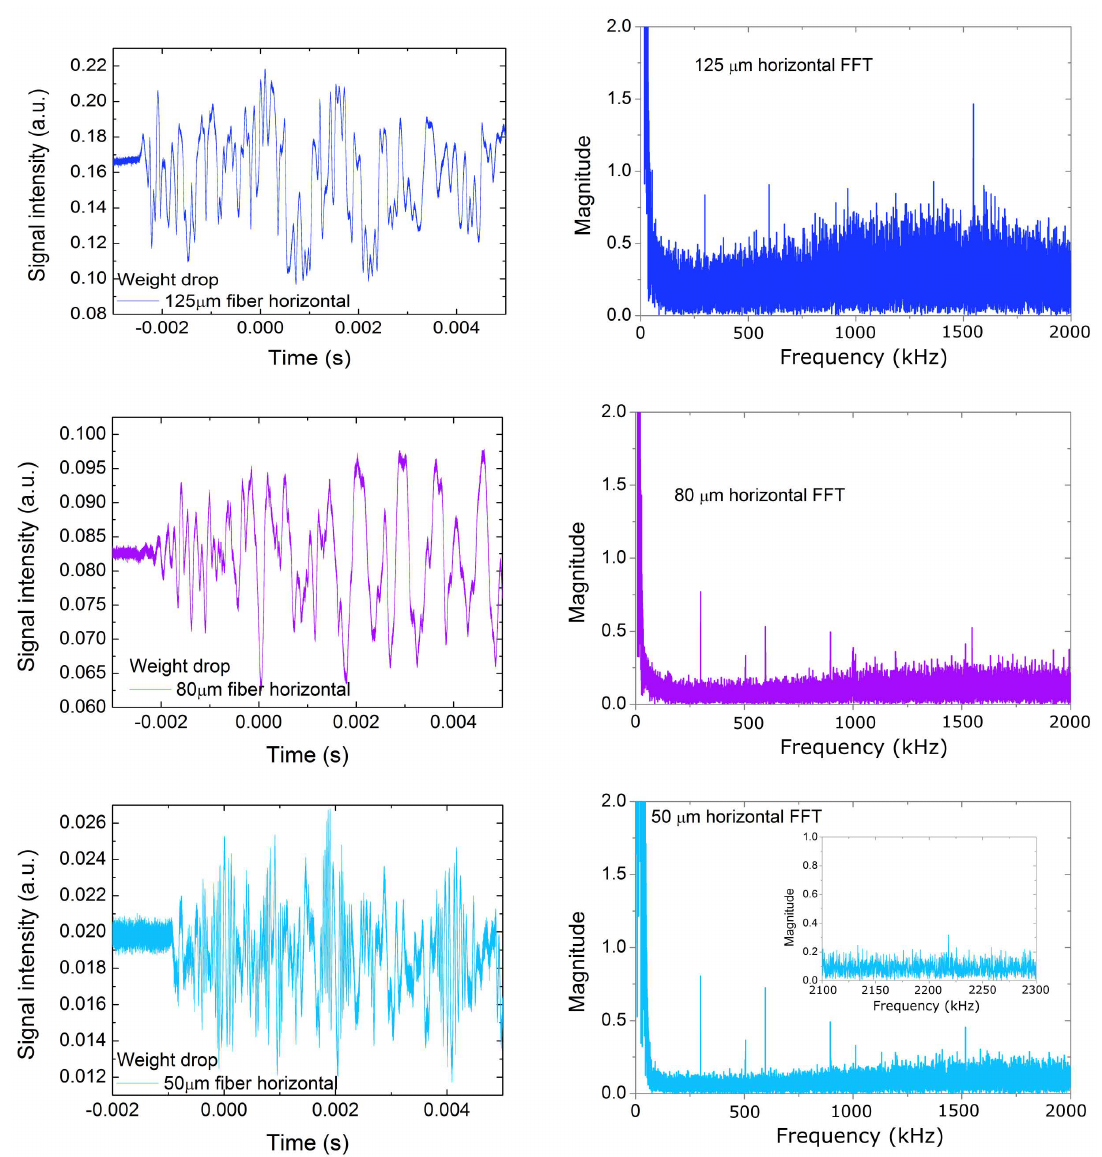
Figure 4. Left column: acoustic waveforms acquired from (top to bottom) 125, 80 and 50 µ m-diameter optical fibers with similar FBGs. Right column: fast Fourier transformation of the waveforms in the right column, focusing on frequencies above 100 kHz.